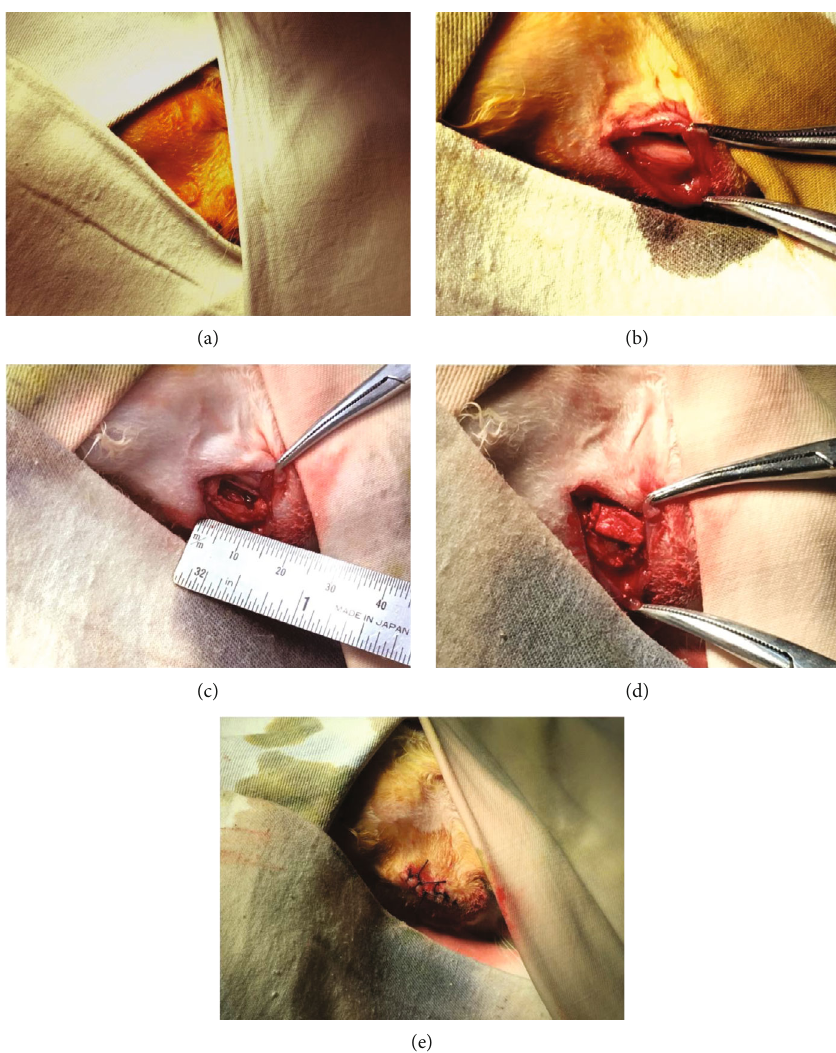
Figure 1: Surgical procedure. (a) Iodophor disinfection operation area and paved sterile disinfection outside the operation area. (b) Exposed rabbit mandible frontiers. (c) A 10 × 4 × 3 mm jaw bone defect. (d) Implantation of the hUC-MSCs+nHAC/PLA construct. (e) Suture